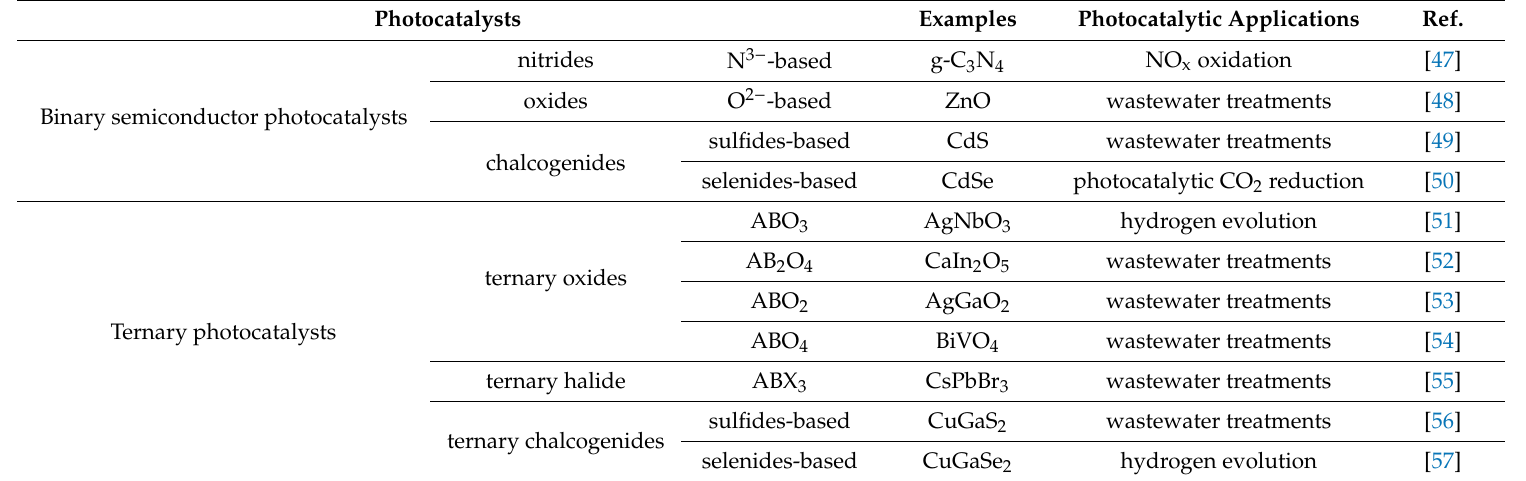
Table 1. Summary of some employed materials for photocatalytic